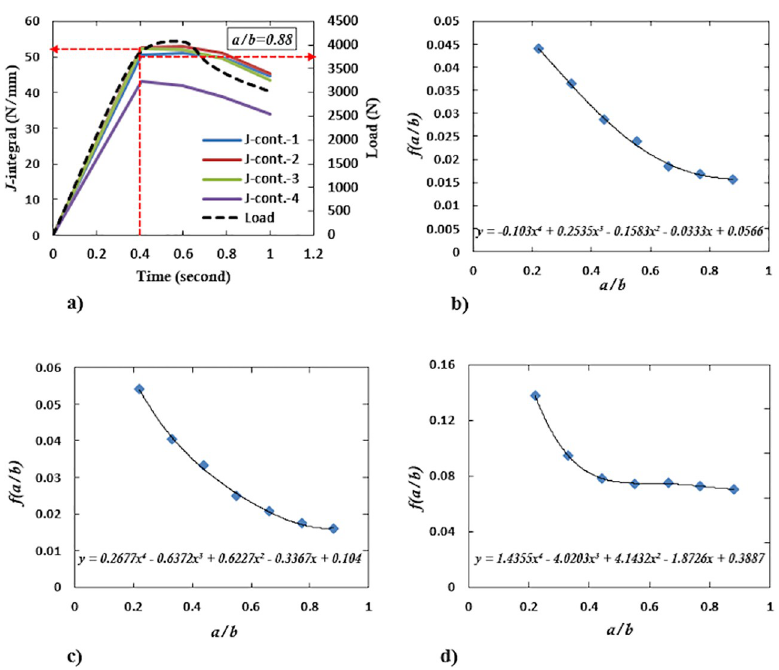
¼ 0 : 88 of TW0/UD0-BC SHC beam with pre-existing skin b